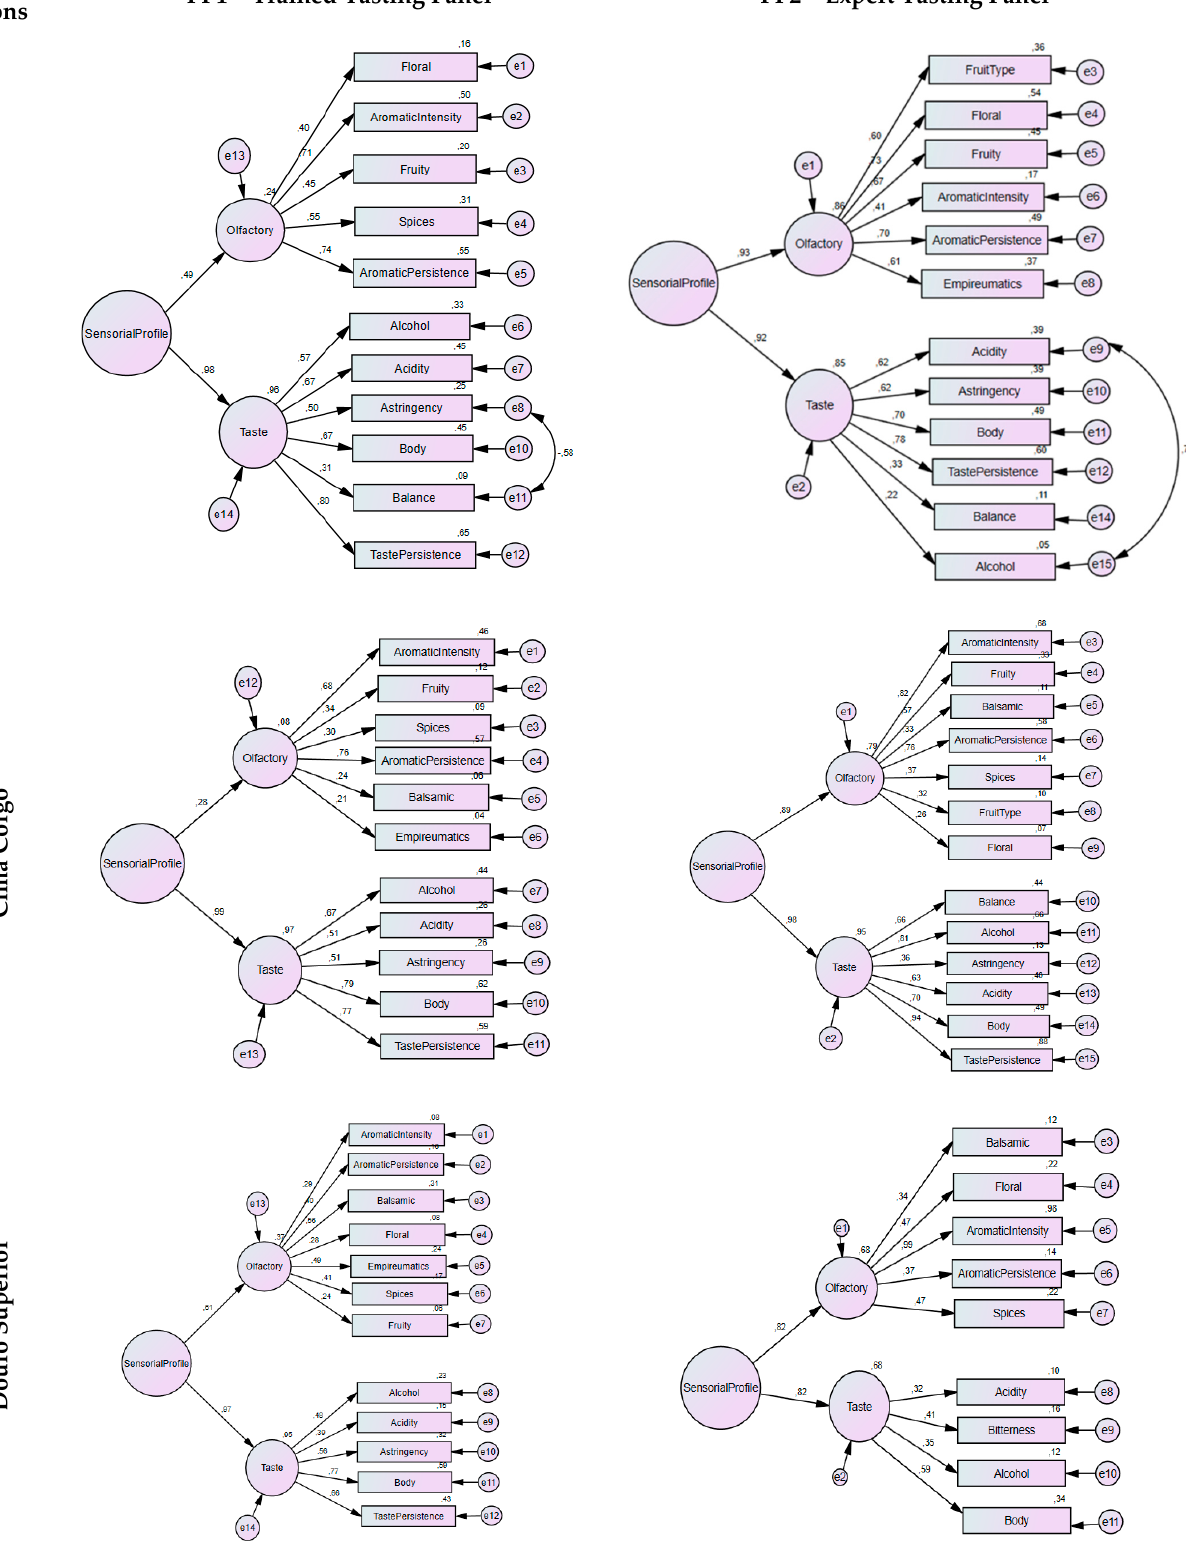
Figure 2. SEM schematic representation, standardized coefficients, and the individual reliability of each of the items in the final second-order model for the sensory profile of the wines of each of the three DDR sub-regions, for both tasting panels, PP1 and